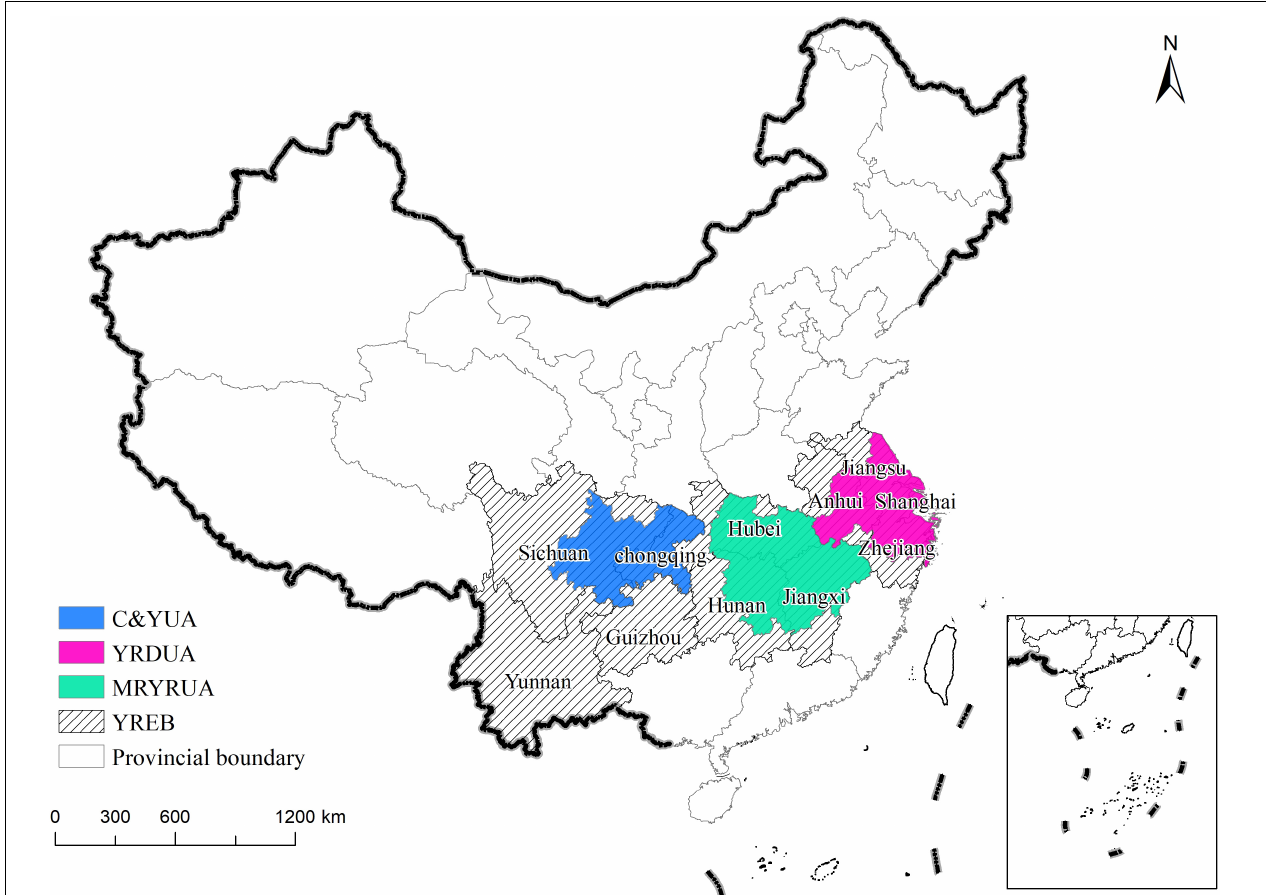
FIGURE 1 | Location of the study area (names in this figure are the names of provinces in